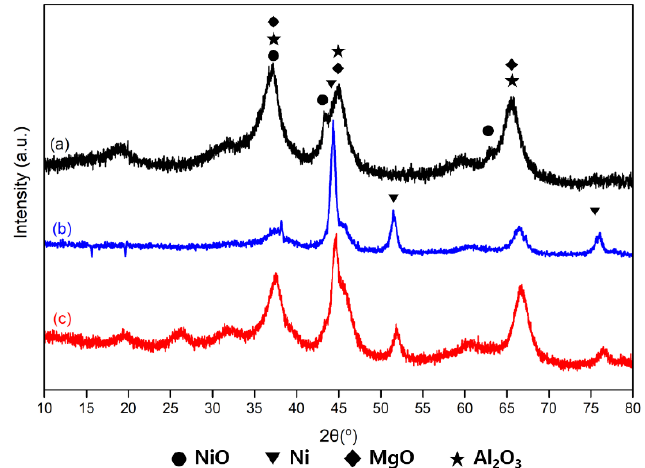
Figure 11. X-ray di ff raction patterns of ( a ) fresh, ( b ) reduced at 700 ◦ C in the fresh state, and ( c ) spent Figure 11. X-ray diffraction patterns of ( a ) fresh, ( b ) reduced at 700 ° C in the fresh state, and ( c ) spent 20 wt% Ni-Mg-Al 20 wt% Ni-Mg-Al catalysts.